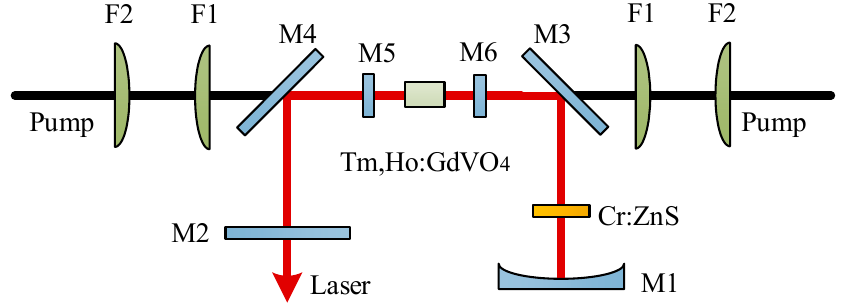
Figure 1. Sketch of experimental setup.